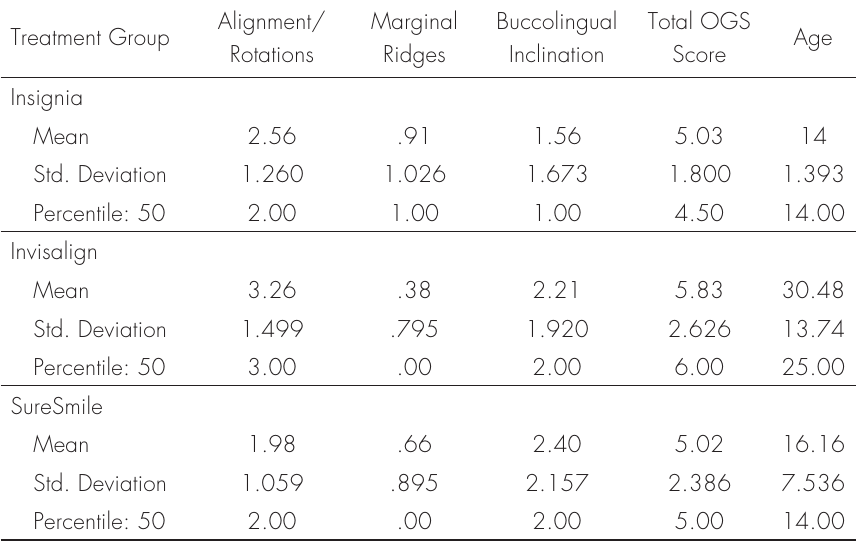
Table XI. Objective Grading Score (OGS) descriptive statistics for each treatment category.